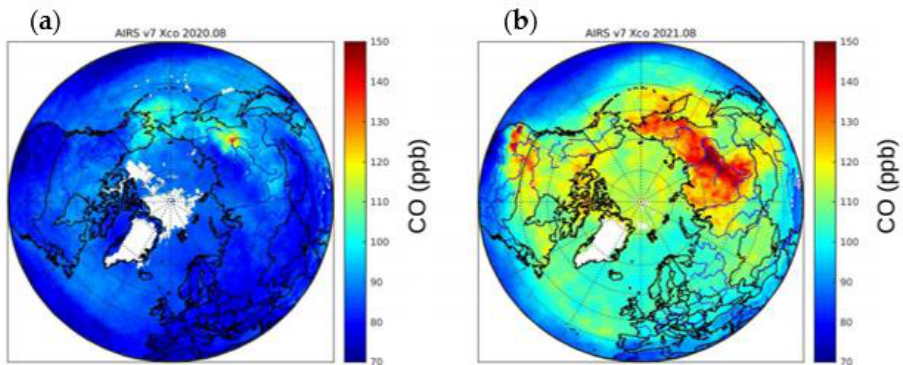
Figure 2. Monthly mean Xco for August 2020 ( a ) and August 2021 ( b ) measured by AIRS. Southern boundary of the maps is 30° N.